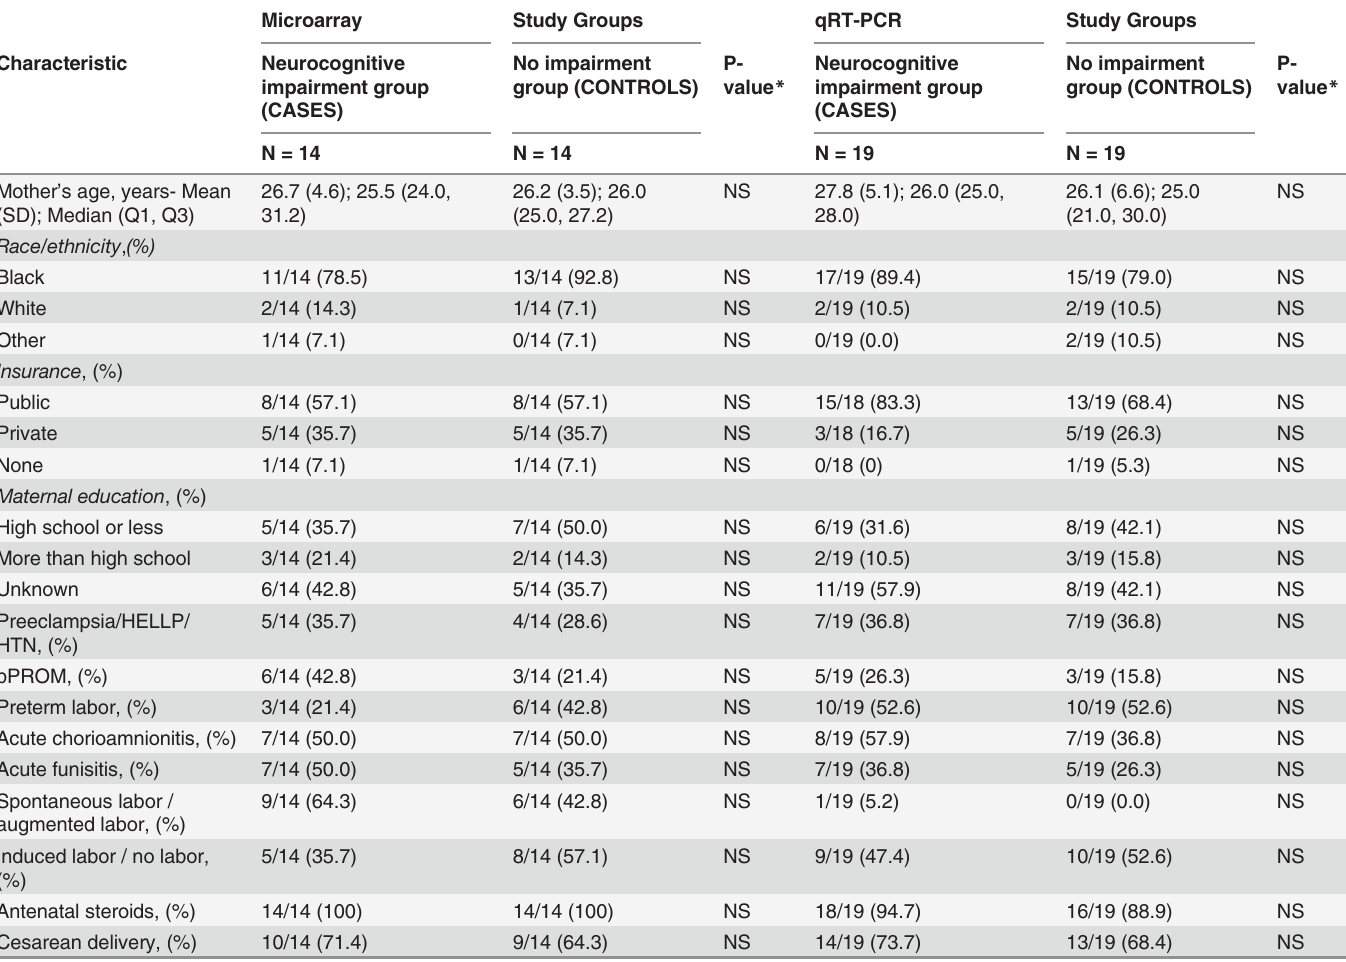
Table 1. Baseline maternal characteristics of the two study groups.